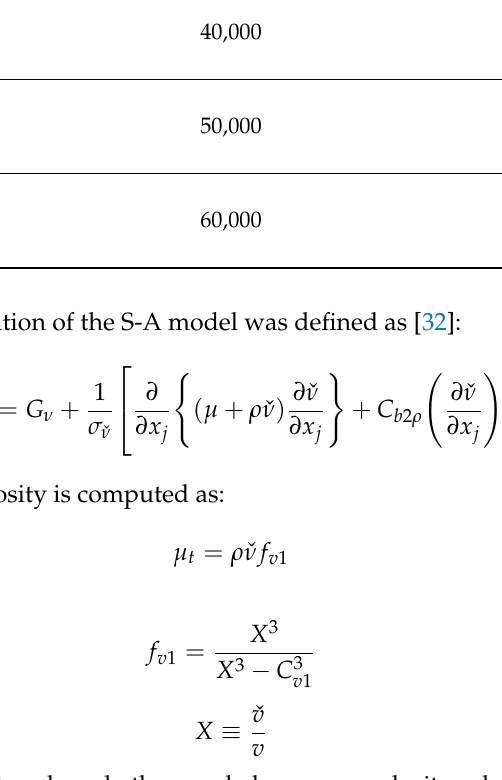
Table 3. Numerical cases for the simulated model.